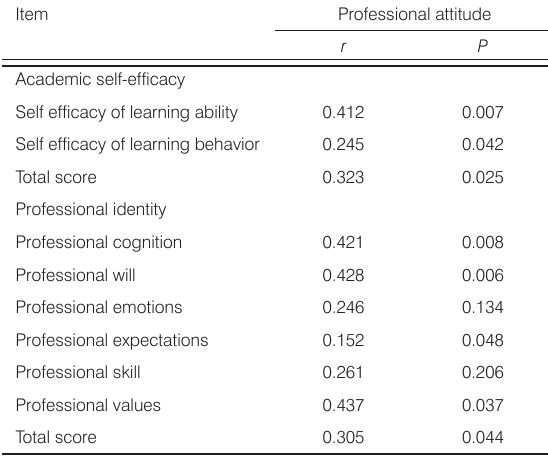
Table 2. Correlation analysis on professional attitude, academic self-efficacy, and professional